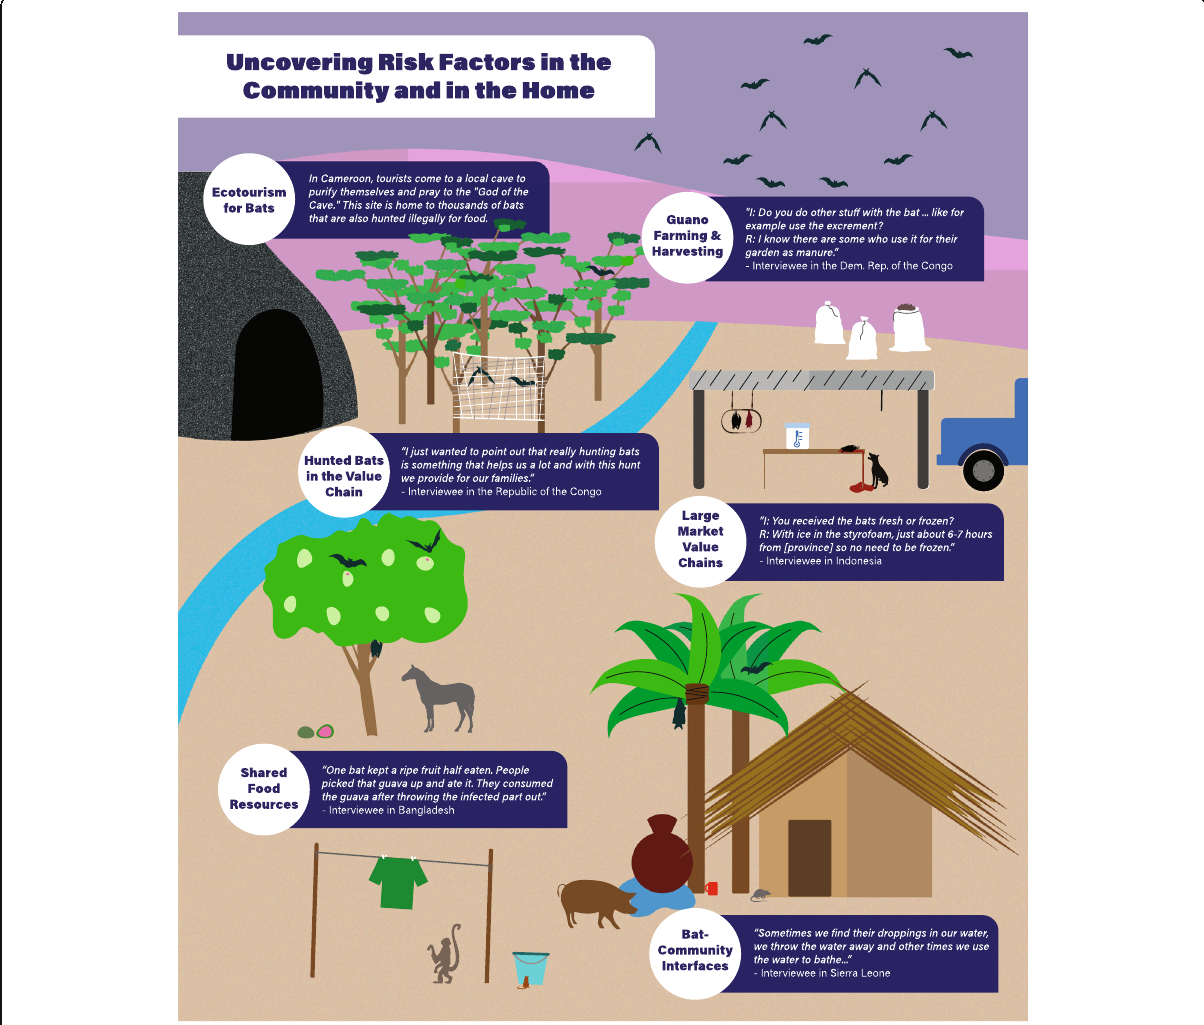
Fig. 5 While human-bat interactions were unique by country and context, key themes ranging from bat hunting to bat-community interfaces were commonly shared among the countries conducting qualitative research. This figure presents cross-country examples of how interviewee ’ s describe local interaction with wildlife, particularly